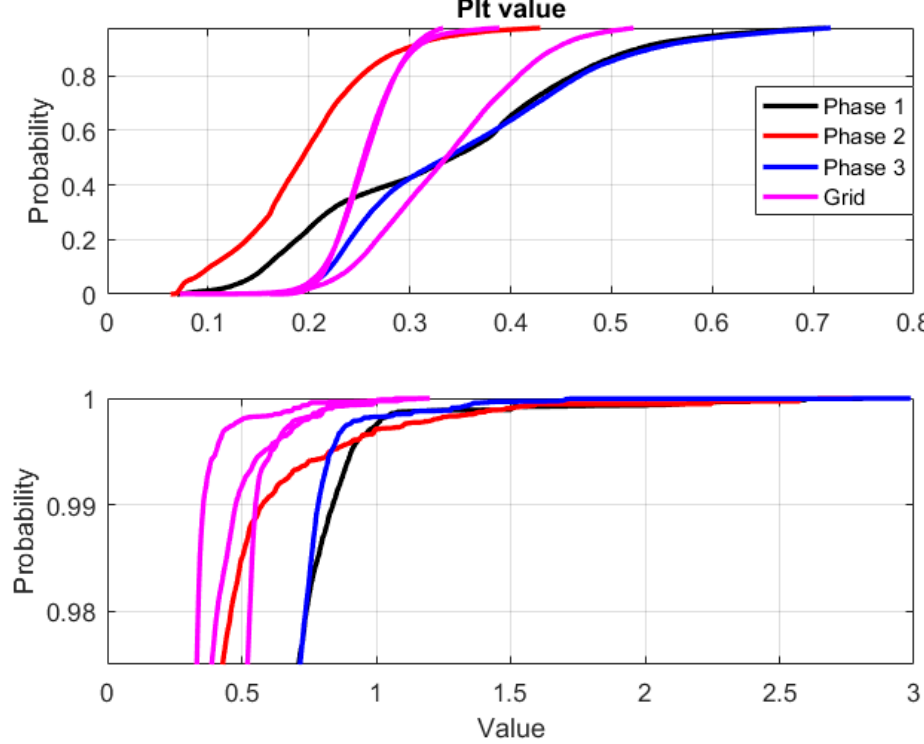
Figure 10. CDF for the Plt values in grid-connected and islanded operation where the interval 0 to 97.5% is displayed at the top and the remaining upper 2.5% is displayed in the bottom. The black, red and blue color represents phase 1 to 3 in islanded mode. Purple color represents all three phases during grid-connected operation. Table 5. 95% confidence interval, the maximum 10 min value and total average value for all three phases in islanded and grid-connected operation.